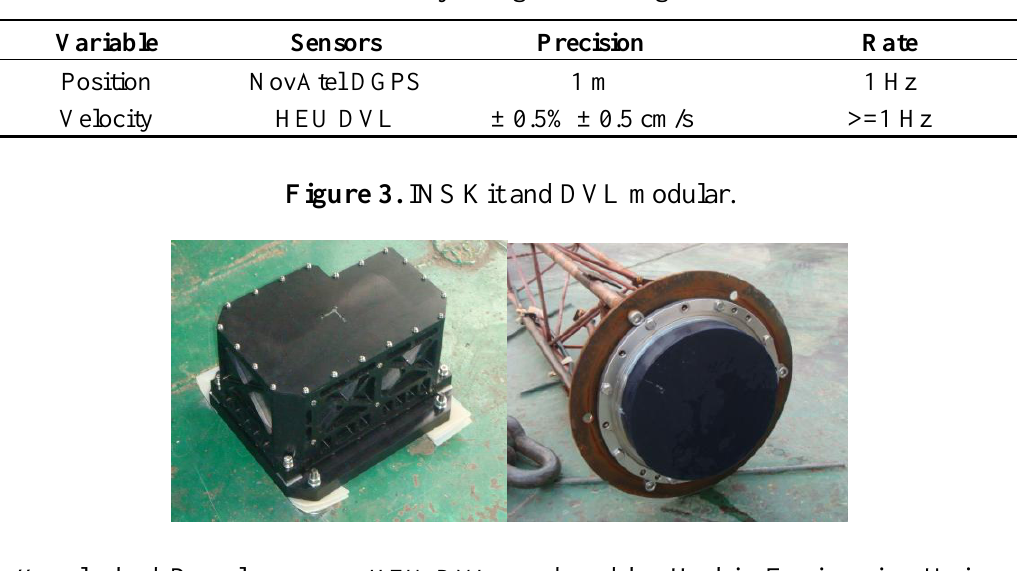
Table 2. Primary navigation aiding sensors.